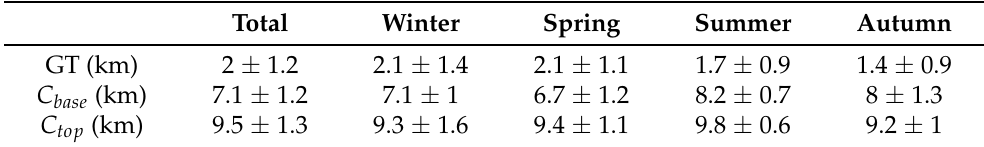
Table A1. Total and seasonal descriptive statistics of cirrus layer geometrical properties, including both COD regimes .